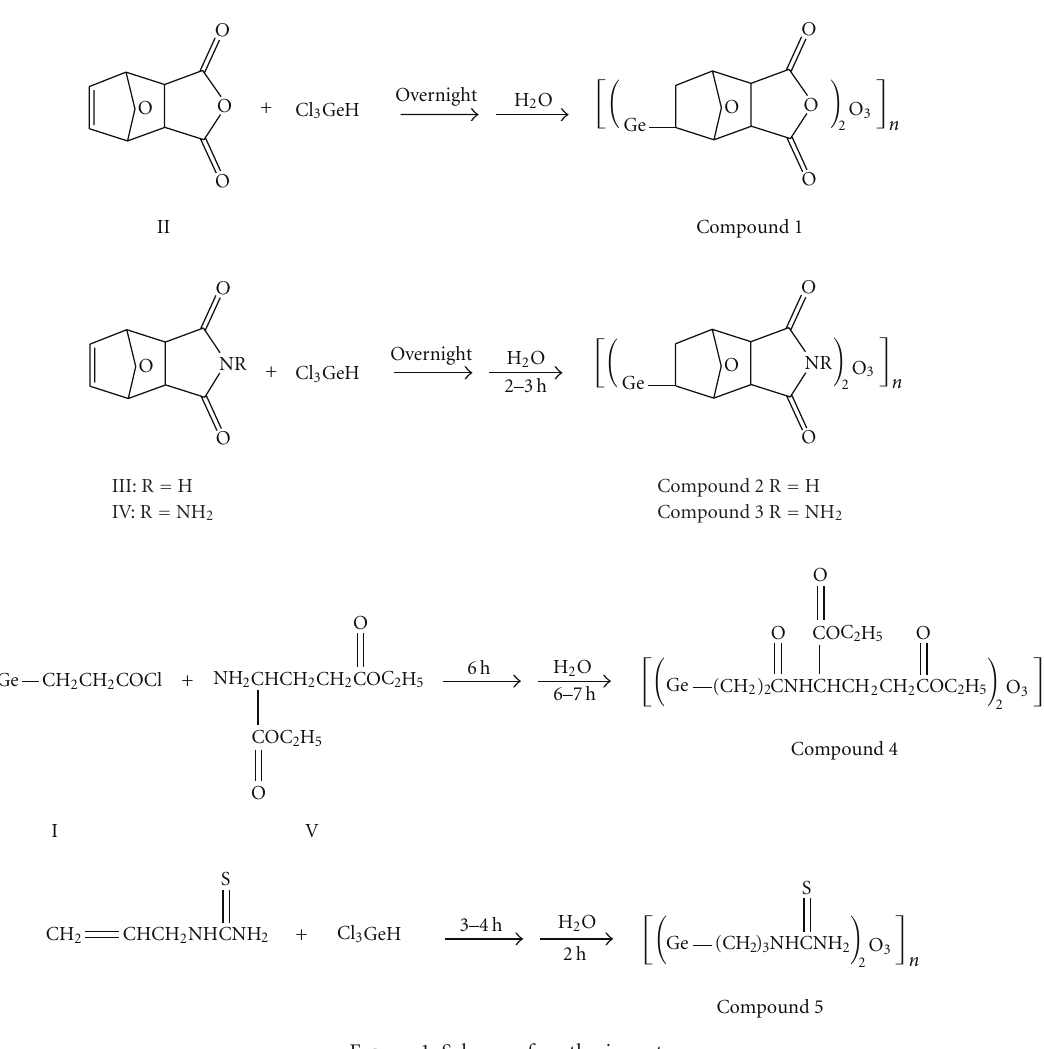
Figure 1: Scheme of synthesis route.